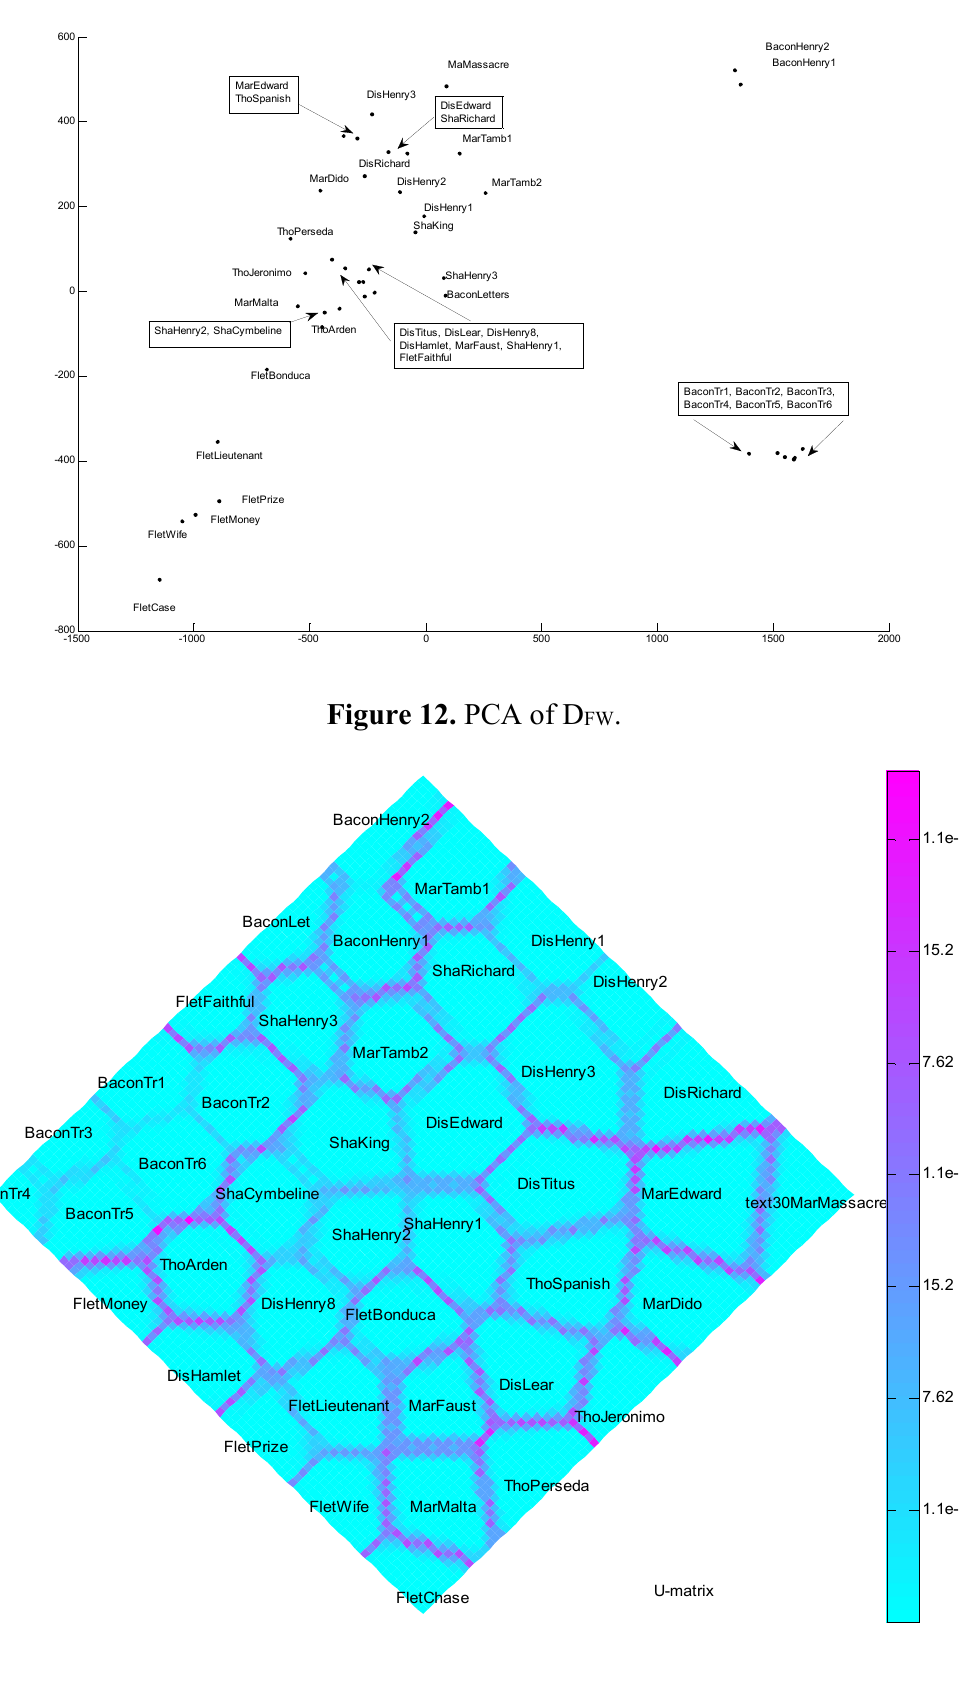
Figure 13. SOM U-matrix of D FW